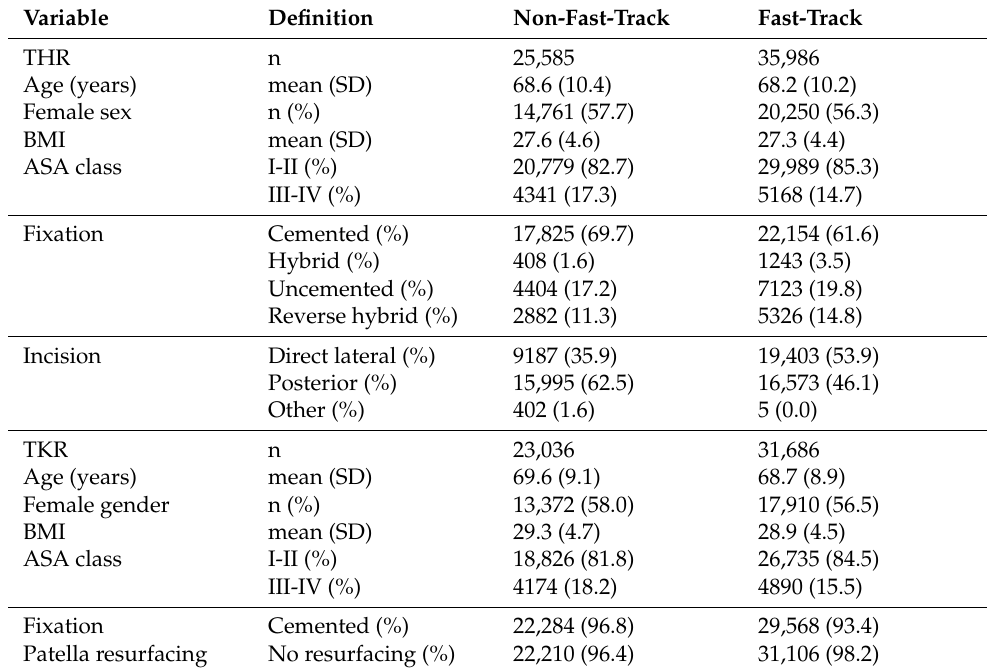
Table 1. Demographic and surgical data on THR and TKR operations